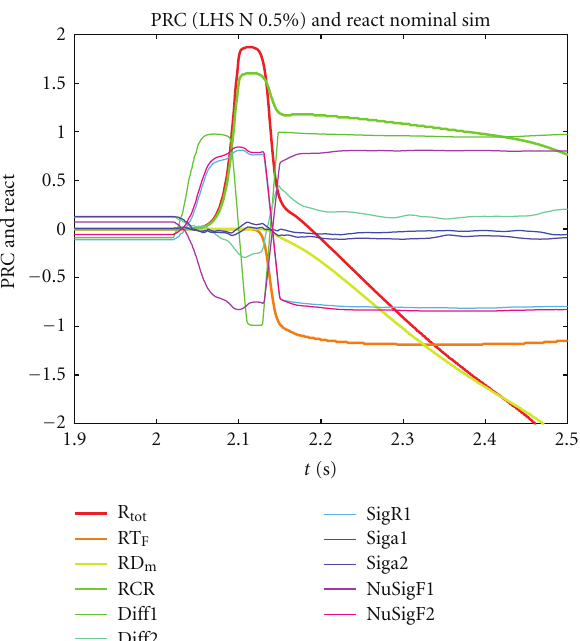
Figure 13: PRC coe ffi cient related to the reactivity and the